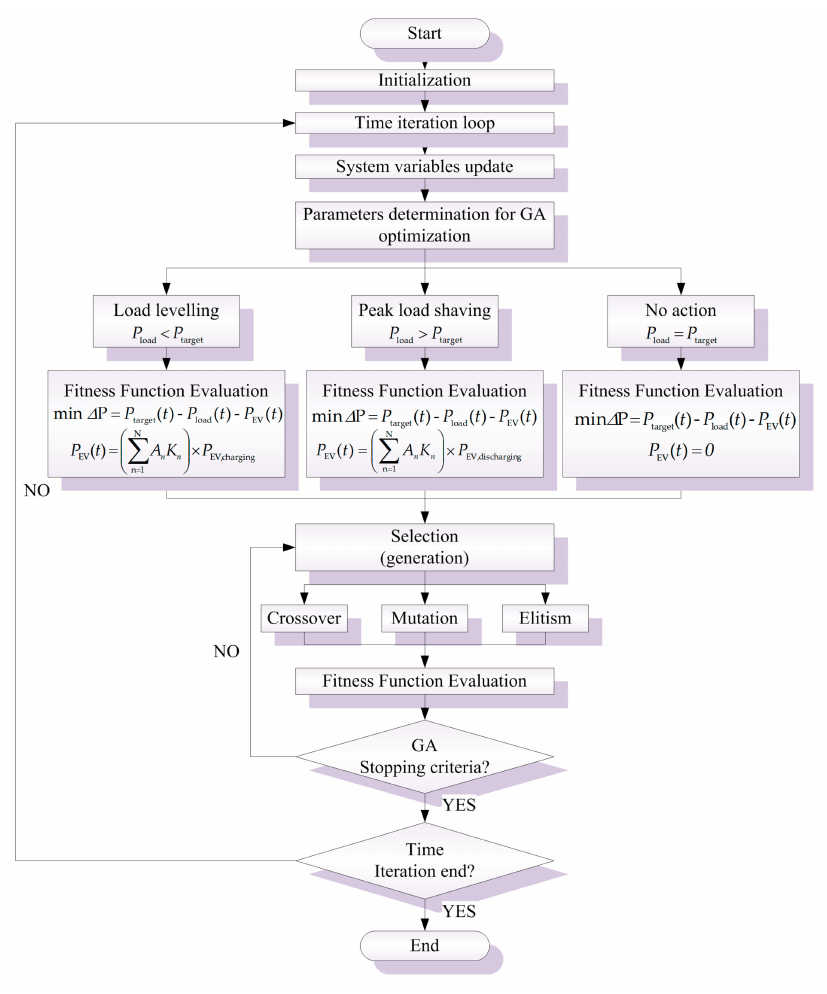
Figure 5. Flowchart for the proposed V2G optimization